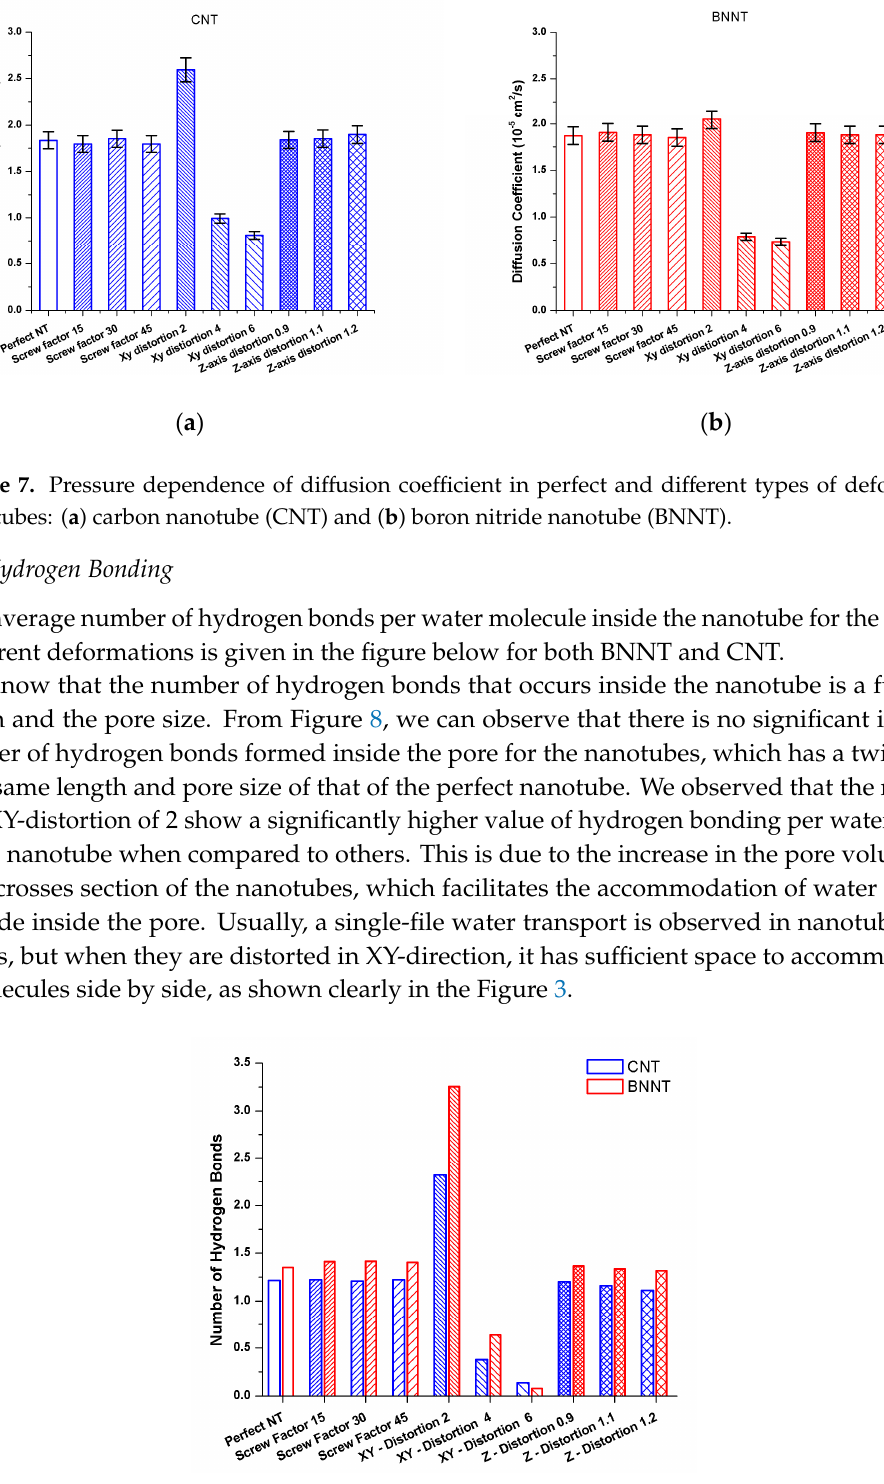
Figure 8. Average number of hydrogen bonds per water molecule formation inside the pore for perfect and different types of deformed nanotubes: carbon nanotubes (CNT) and boron nitride nanotubes (BNNT).